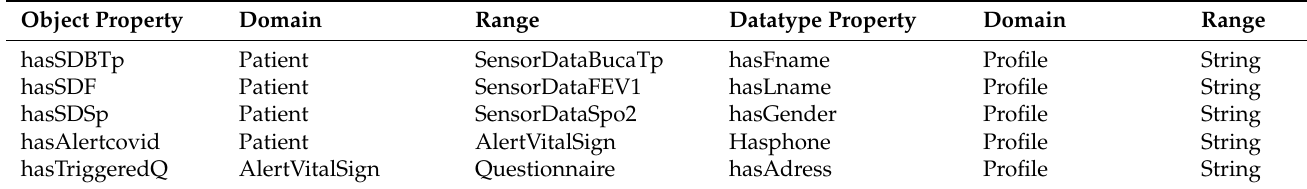
Table 5. Some concepts of evaluation vital sign